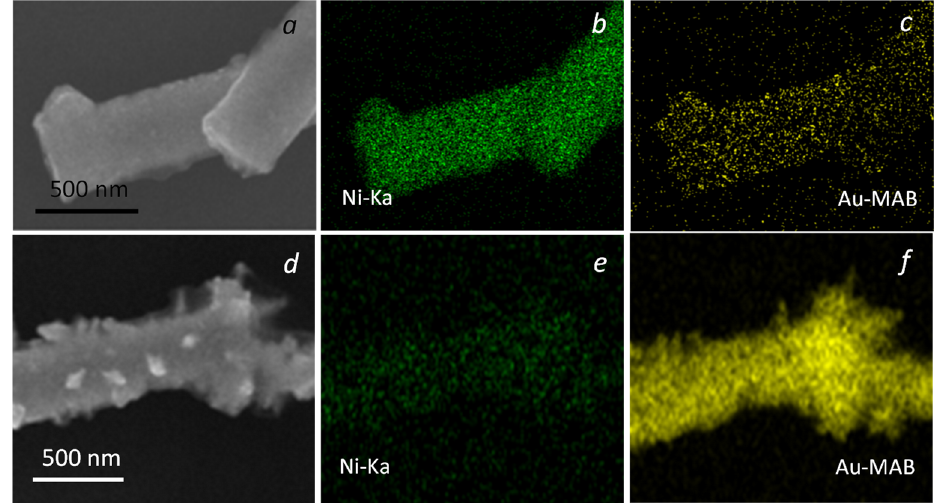
Figure 3. SEM image ( a , d ), nickel and gold mapping ( b , c , e , f ) for Ni@Au NTs prepared with different concentration of Au 0.005 M ( a – c ) and 0.01 M ( d – f ), respectively. The images for 0.01 M concentration are similar to those published in [39].